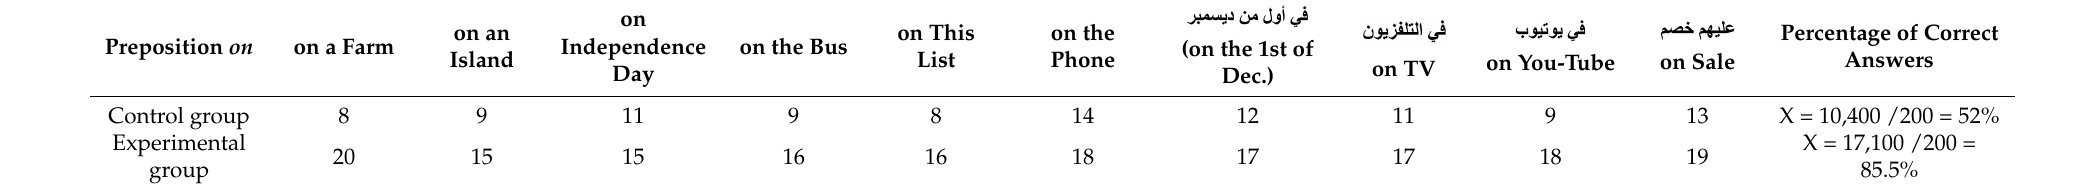
Table 7. Posttest 1 for the preposition on .